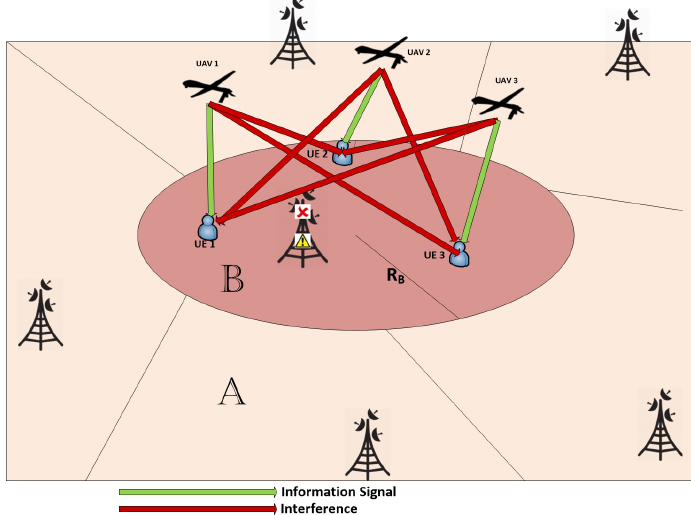
Figure 2. System model illustration of the information and interference signals for N UAV = 3 and N UE =